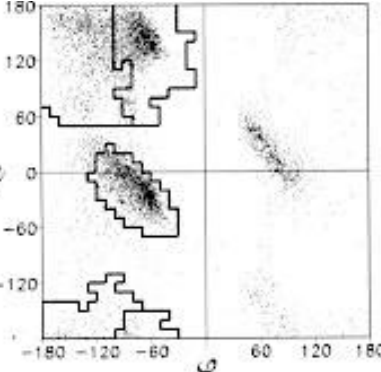
Figure 2. Ramachandran distribution of the sterically allowed region of amino acid residues in coil libraries. The two regions in the upper left and lower left quadrant are associated with β-strand and polyproline II (p), respectively. The region crossing the ψ = 0 line in the left part of the plot contains right-handed helical and turn-supporting conformations. Taken from [15] and modified.